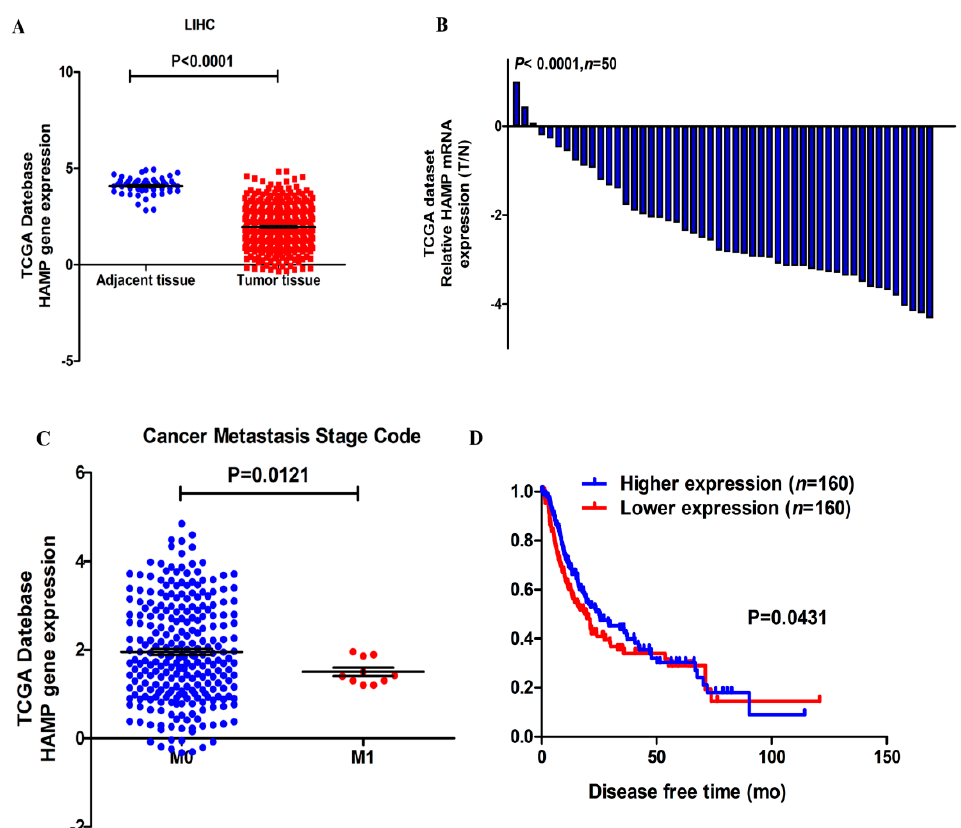
Figure 1. HAMP expression is reduced in liver hepatocellular carcinoma (HCC) and low HAMP expression is linked to higher cancer metastasis stage code and poor disease-free status. ( A ) HAMP expression in HCC tumors was significantly decreased relative to adjacent liver tissue ( p < 0.0001). ( B ) Histogram showing HAMP expression in liver hepatocellular cancer. The 2 − ∆∆ C t approach was used to calculate HAMP expression, and expression in each patient is given as the tumor (T, n = 50) / normal (N, n = 50) ratio; ( C ) Low HAMP expression is associated with high cancer metastasis in HCC patients ( p = 0.0121). ( D ) Low HAMP expression is associated with poor disease-free status in HCC patients, according to a Kaplan–Meier analysis of HCC ( n = 320, log rank test, p = 0.0431).